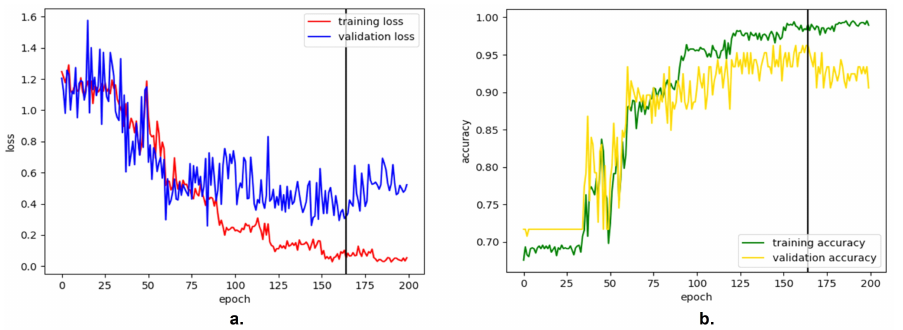
Figure 10. Results of applying learning rate decay and weight decay. ( a ) Training and validation for model training. ( b ) Training and validation for accuracy training. Table 3. Network Architecture and Hyper-parameters: Several experiments were performed to finalize this architecture and hyper-parameters settings. These settings offered the most relevant